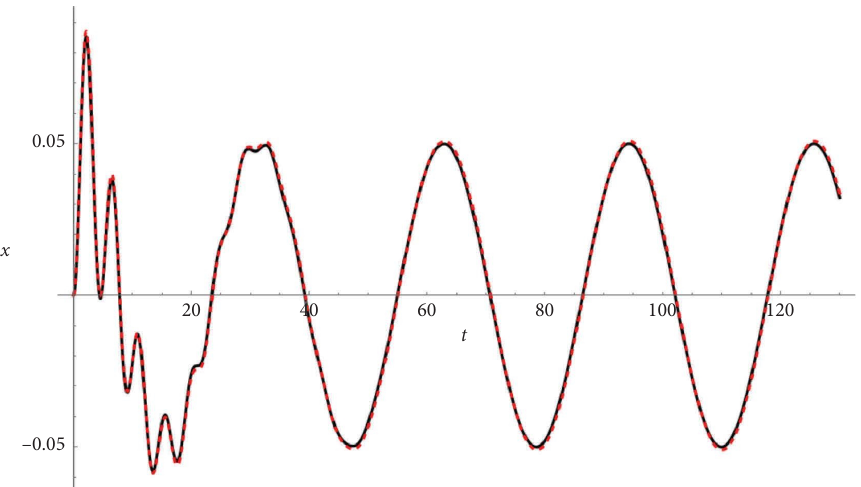
Figure 4: Real part compared with the Runge–Kutta numerical solution.